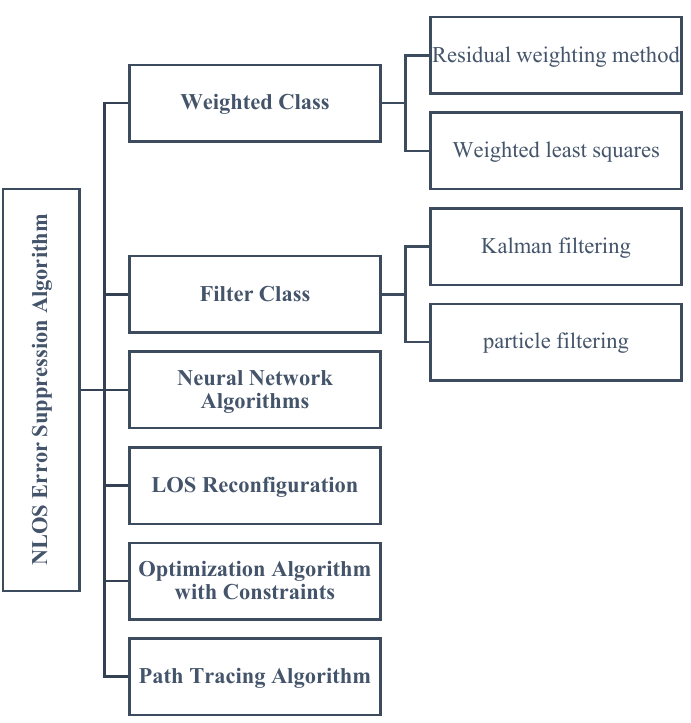
Figure 3. Classi fi cation of NLOS error suppression algorithms. Figure 3. Classification of NLOS error suppression